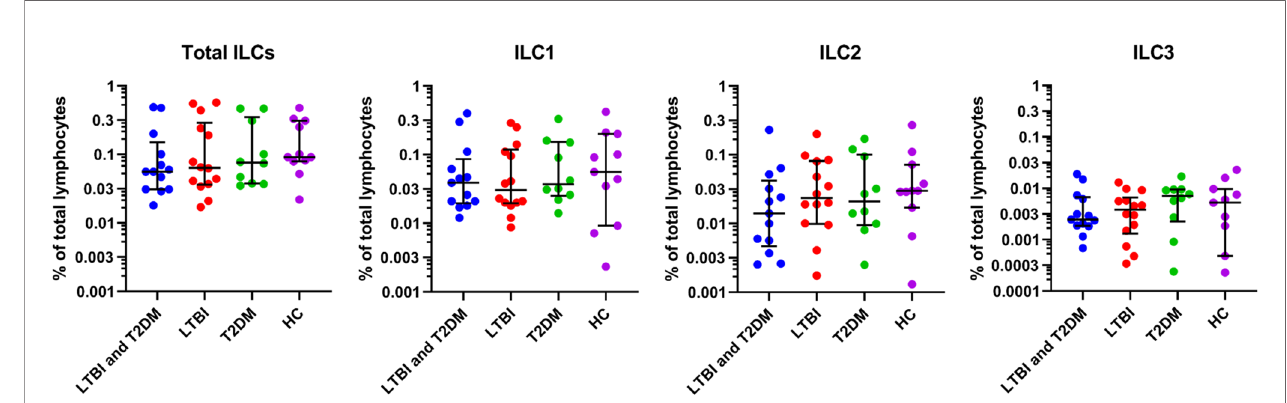
FIGURE 2 | For identi fi cation of total ILCs, ILC1, ILC2, ILC3; PBMCs were stimulated and cultured for 6 hours with PMA/ionomycin plus Brefeldin A and stained for surface markers. Size of groups: LTBI and T2DM (n = 13), LTBI (n = 14), T2DM (n = 10), and HC (n = 11). Data represent medians and interquartile ranges. The non-parametric Kruskal-Wallis and Mann-Whitney U tests were used to determine the statistical signi fi cance between the medians. Differences were considered statistically signi fi cant at P < 0.05 and 95% con fi dence level. Non-signi fi cant P-values were